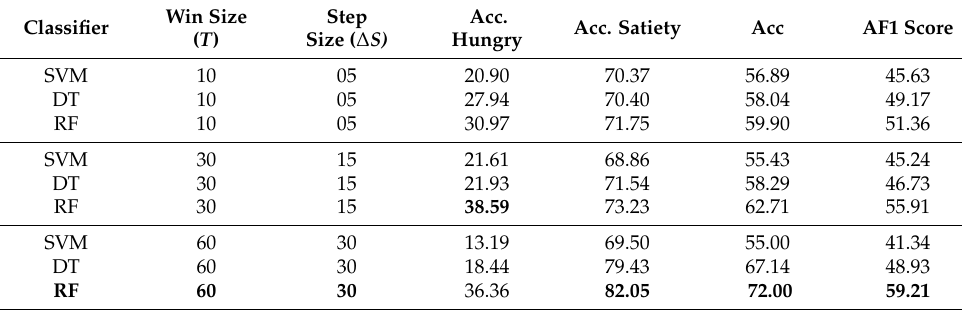
Table 5. Results of binary classification of hunger and